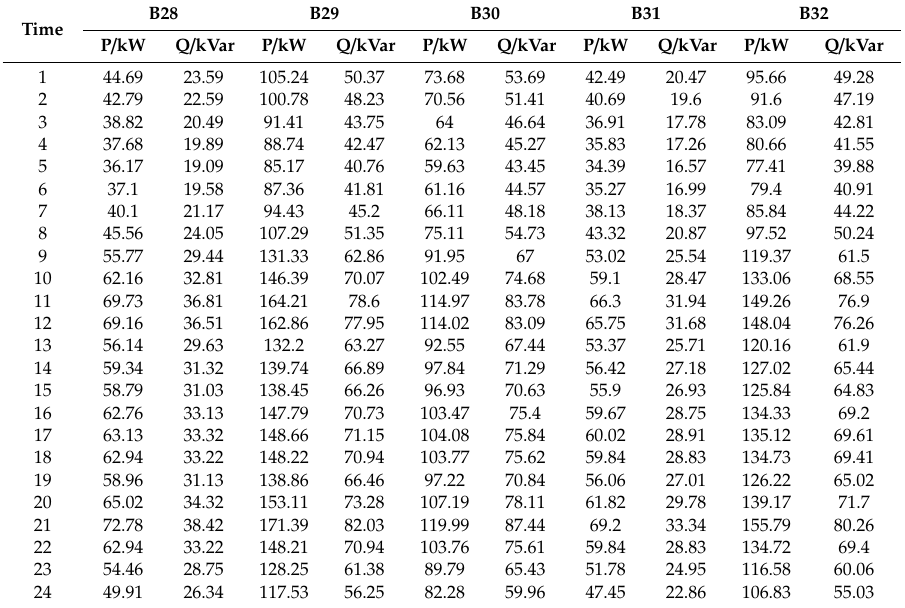
Table A5. The bus load at di ff erent time of nodes28–32.